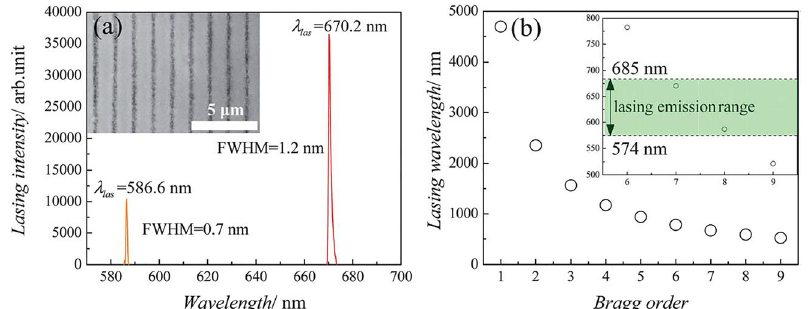
Figure 10: (a) The lasing spectrum of the dual-wavelength laser and (b) the calcu- lated lasing wavelength positions of the DCM-doped HPDLC grating with a period of 1520 nm for different Bragg orders. The inset in (a) is the SEM image of the grating, andtheinsetin(b)isanampli fi cationofthe data from the 6 to 9 Bragg orders